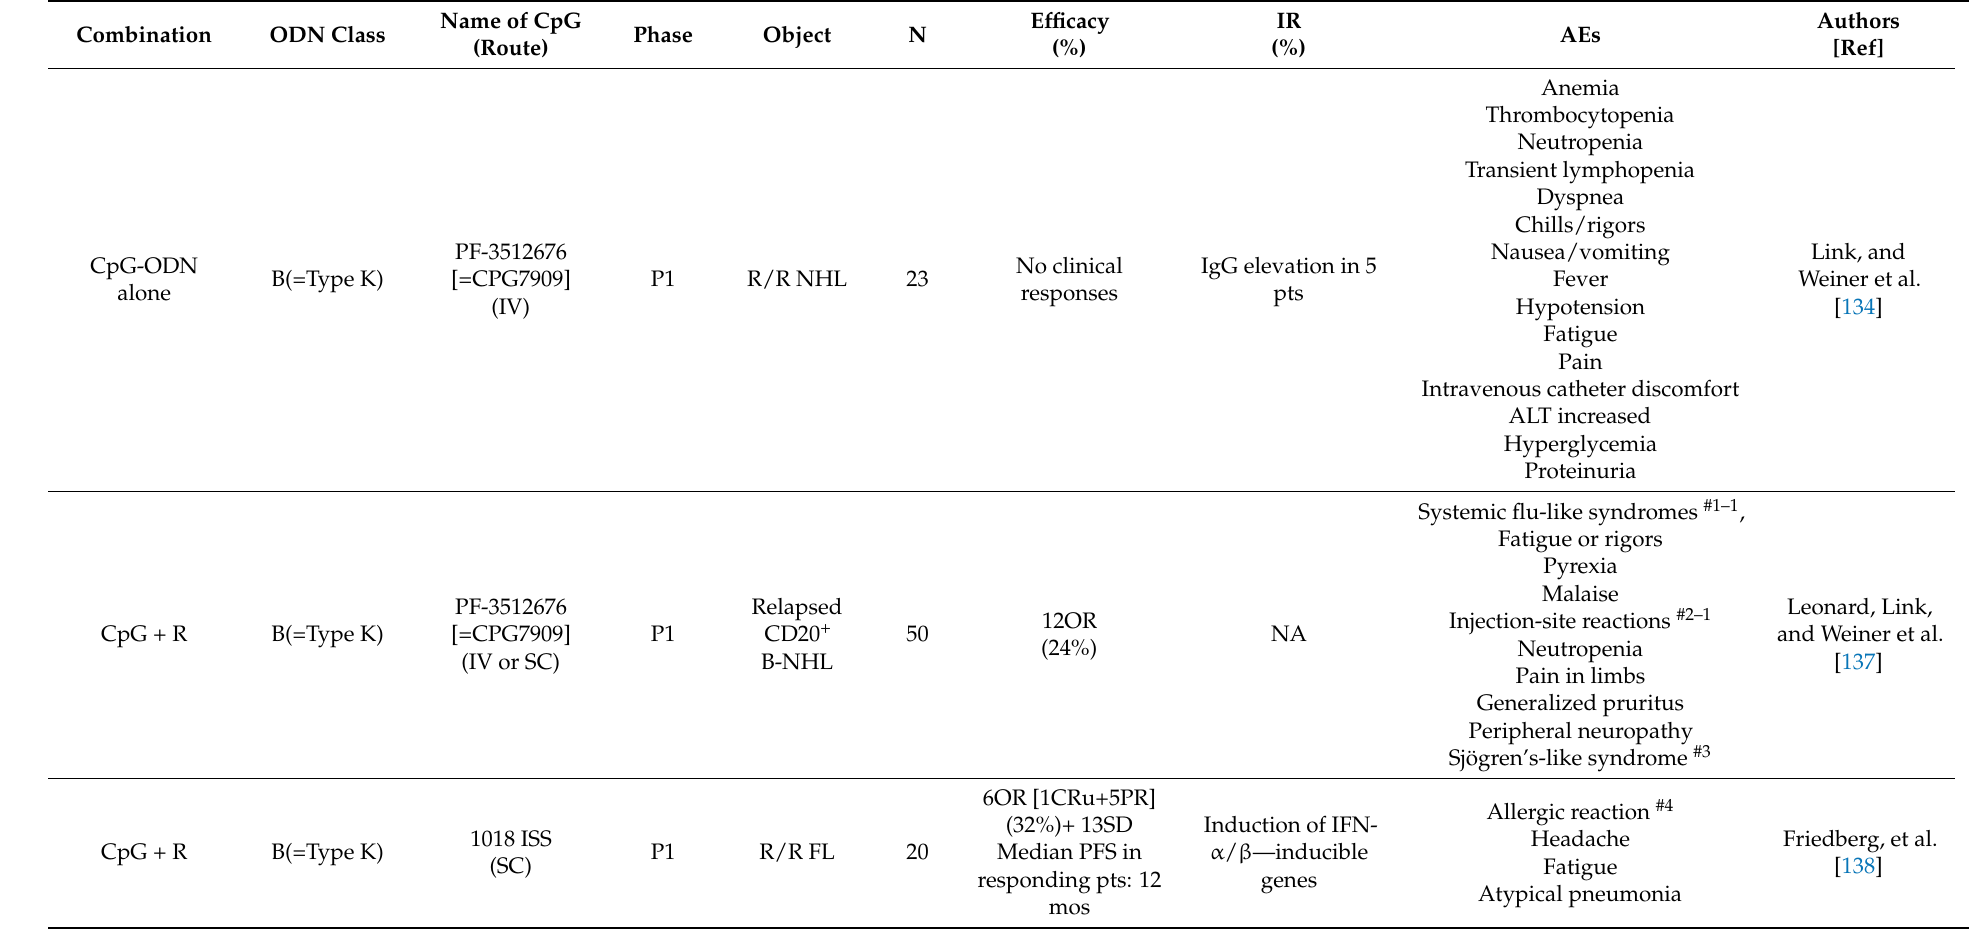
Table 1. Clinical trials and mouse studies of CpG-ODN alone or in combination with other